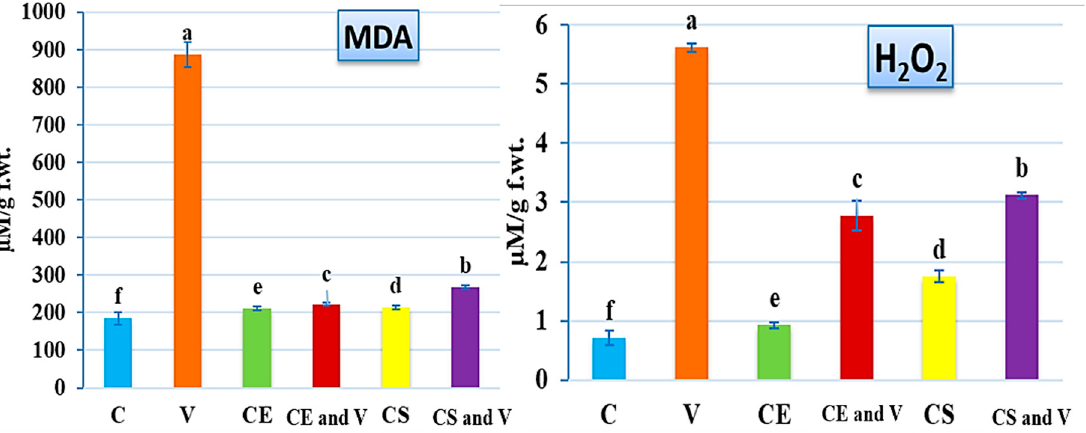
Figure 6. Effect of the foliar application of nanoclay on the MDA and H 2 O 2 of potato plants at 28 days after PVY inoculation. C: control potato plants; V: potato plants inoculated with PVY; CE: potato plants treated with Egyptian nanoclay; CE and V: potato plants inoculated with Egyptian nanoclay 48 h before PVY inoculation; CS: potato plants treated with standard nanoclay; CS and V: potato plants inoculated with standard nanoclay 48 h before PVY inoculation. The columns reflect the average value of five biological replicates, while the bars represent the standard deviation (SD). According to Tukey’s HSD test ( p ≤ 0.05), the values of each column following the same letter (a/b/c/d/e/f) do not significantly differ.